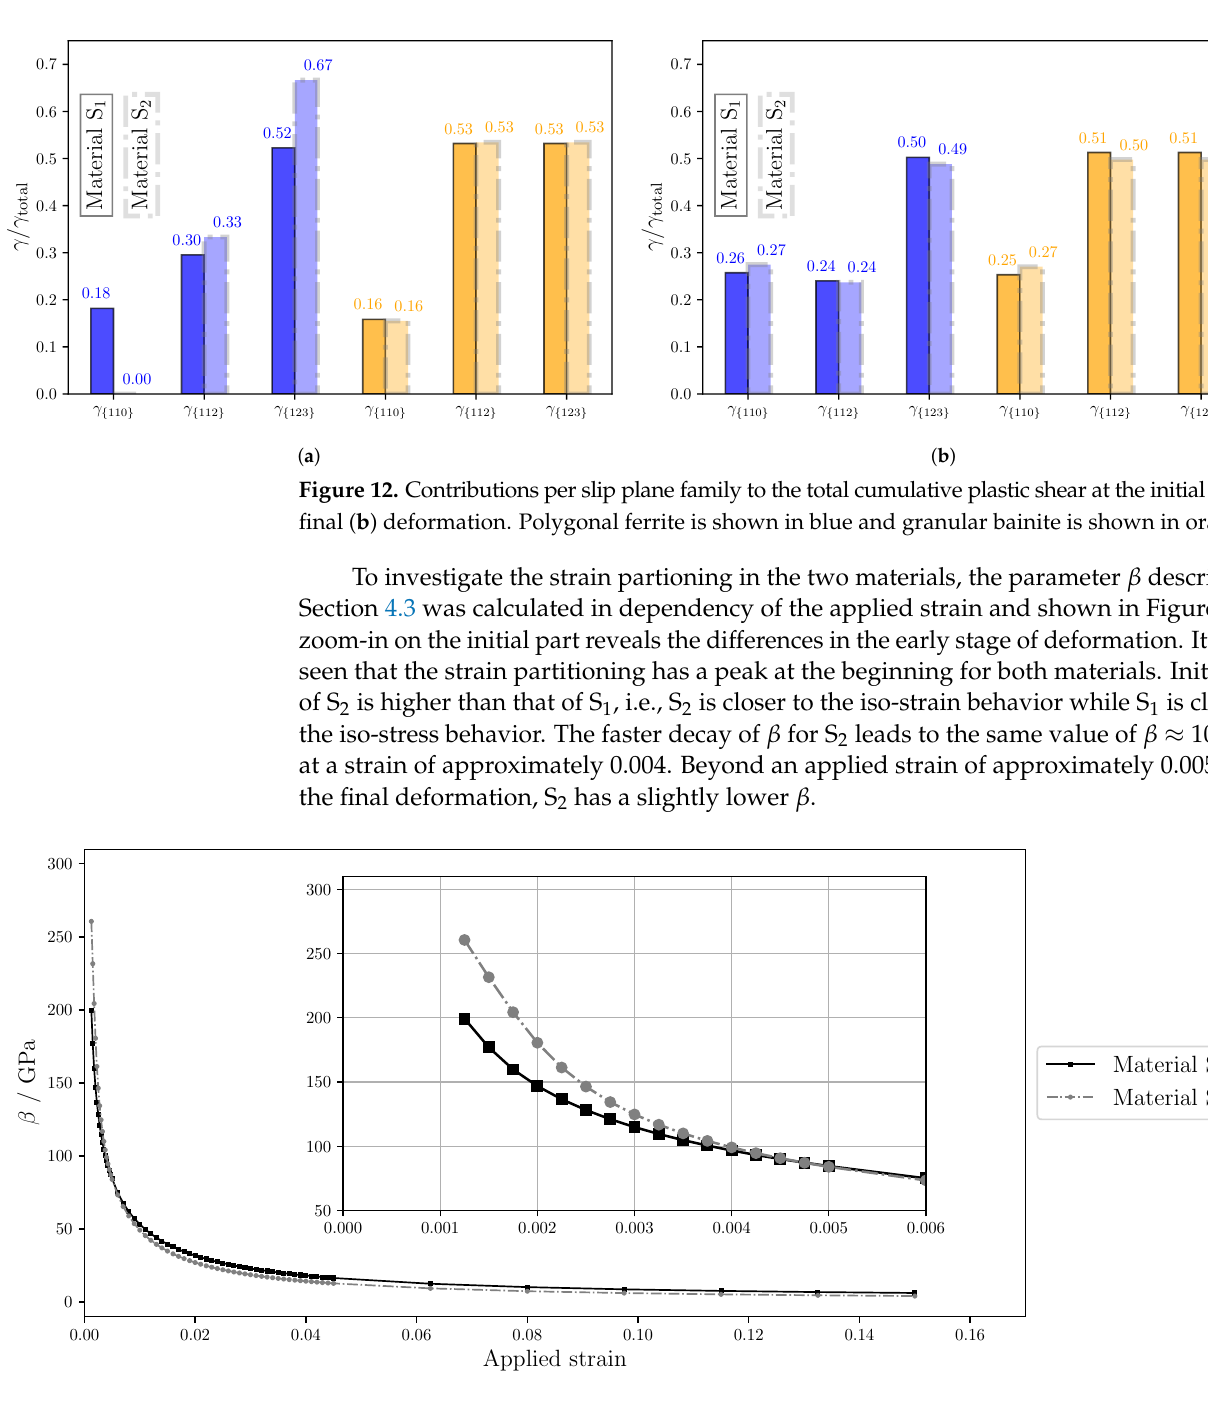
Figure 13. Strain partioning parameter β against the applied strain. Finally, the results for the three different laws of mixtures, as introduced in Section 4.3, are shown in Figure 14. The left column of Figure 14 shows the results from the simulation output. The orange line corresponds to the average response among all points of GB. Analogously, the blue line corresponds to the response of PF. The black line, which is the stress–strain curve for the material, was calculated from the average response of all points at a given applied strain (gray line). In the middle and right columns of Figure 14, the stress–strain curves of the material (pink line with gray markers) were calculated using the individual stress–strain curve of each phase from the simulation output (blue and orange lines) and applying different assumptions (iso-work, iso-strain, and iso-stress).